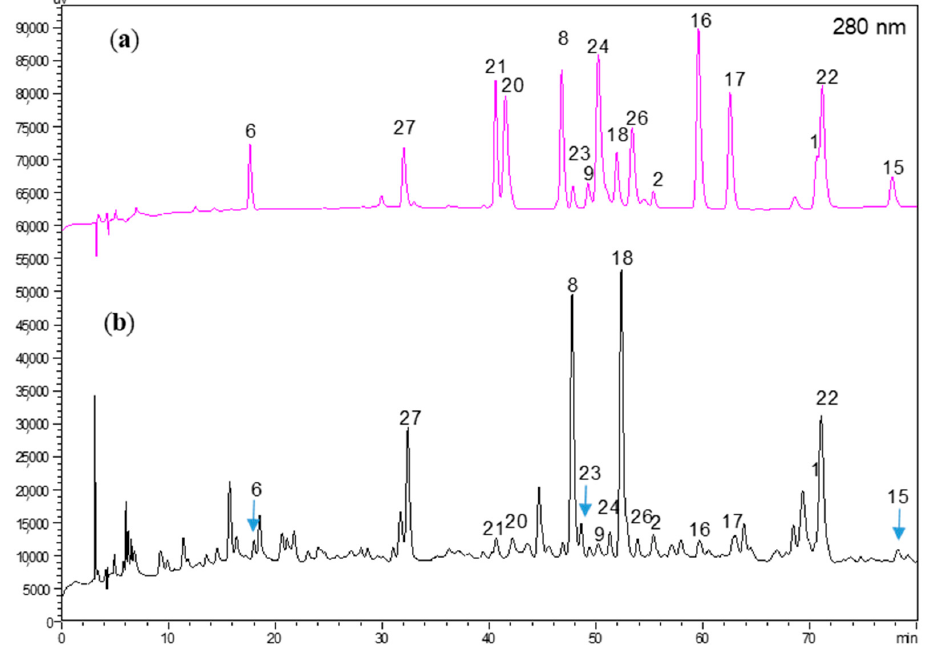
Figure 5. HPLC chromatograms of ( a ) the 16 marker compounds and ( b ) the CLE layer at optimum detection wavelength (280 nm).